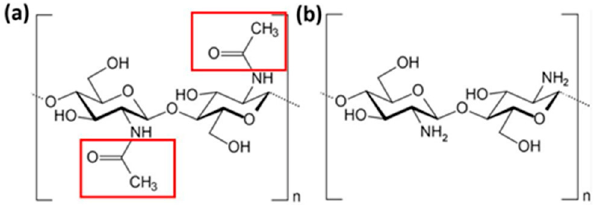
Figure 5 . ( a ) Chemical structure of chitin molecule; ( b ) chemical structure of chitosan. The acetyl group is highlighted in the red box.